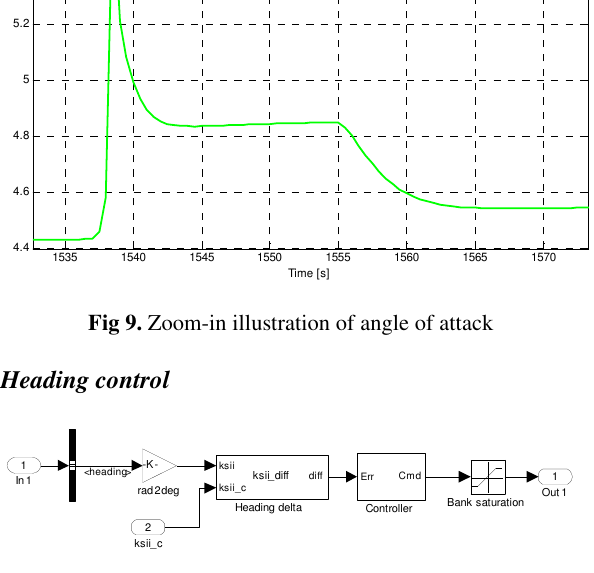
Fig 10. Simple heading and bank angle control algorithm The model described features very simple